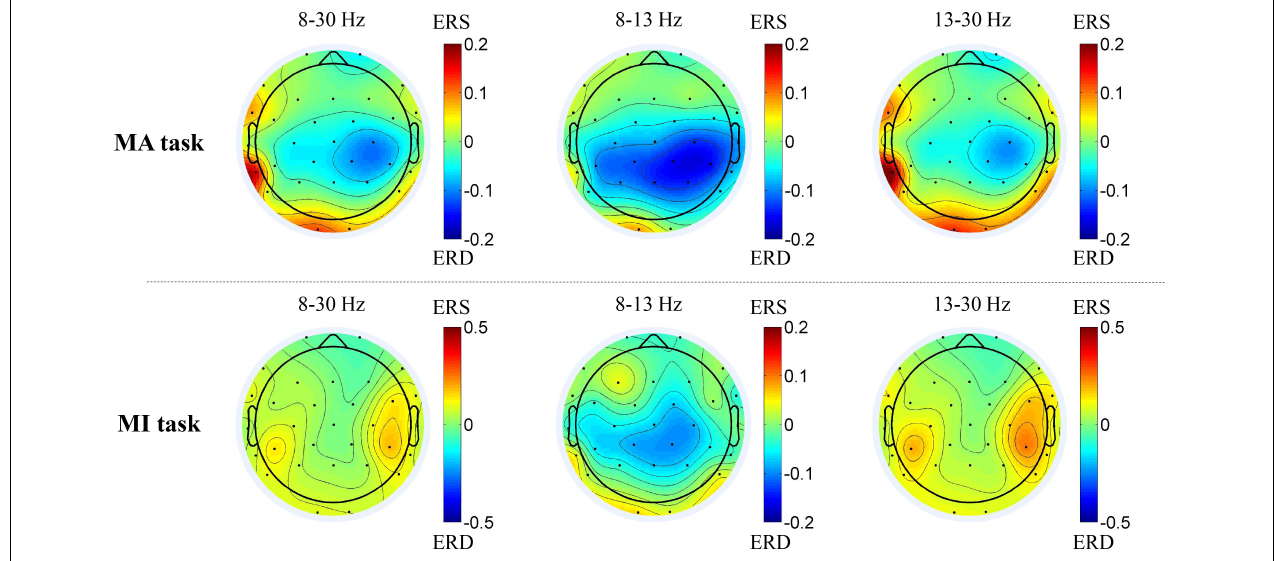
FIGURE 3 | Average topographies of all 14 patients in the 8–30 Hz, 8–13 Hz and 13–30 Hz frequency bands between the MA and MI tasks. The first row shows the average topographies of the 8–13 Hz and 13–30 Hz bands in the MA tasks. The second shows the average topographies of the 8–30 Hz, 8–13 Hz and 13–30 Hz bands in the MI